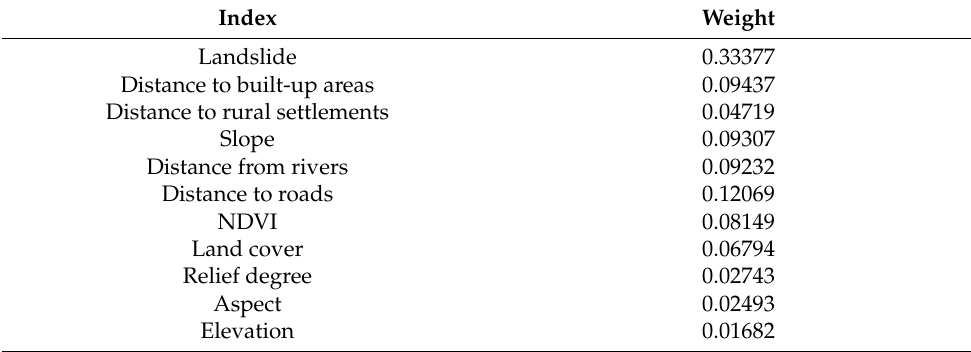
Table 8. Construction land suitability index factor weights.